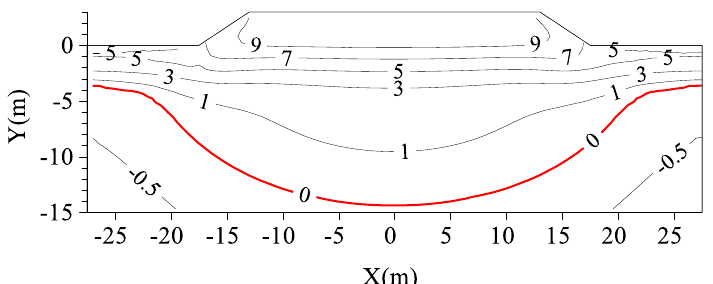
Figure 7. Geotemperature distributions of subgrades without a TPCT on 1 October of the 30th year after construction (Unit: °C).